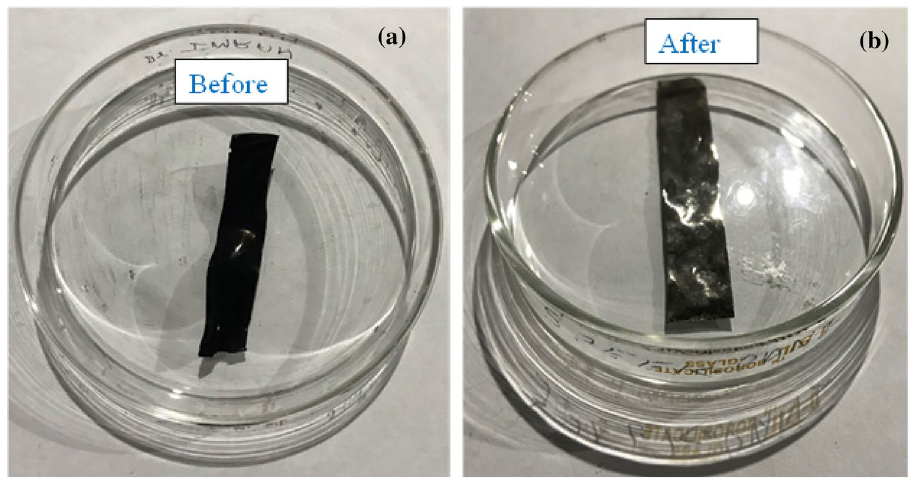
Figure 1. The fabricated membrane before and after coating with PANI and Pt.